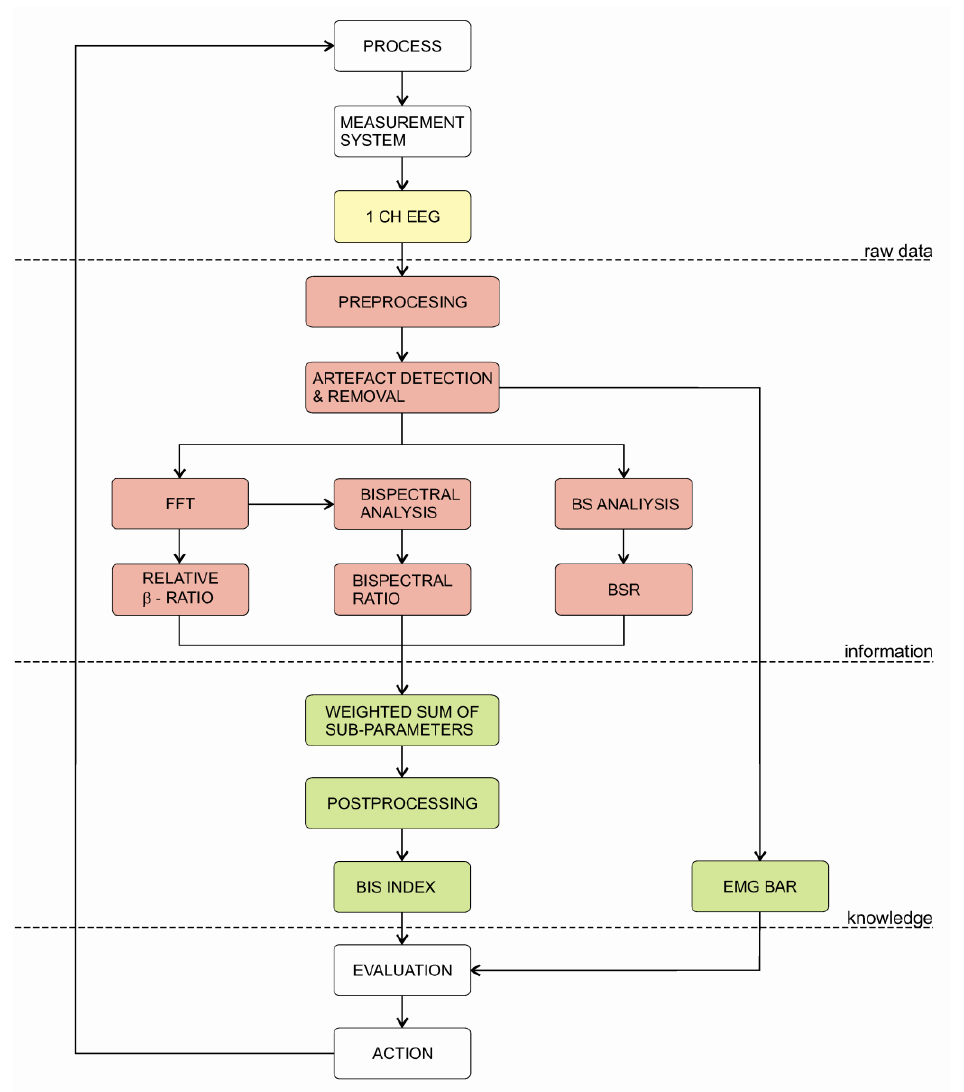
Figure 5. The block diagram of the BIS algorithm. Abbreviations: BSR (burst suppression ratio), electromyogram activity (EMG), FFT (fast Fourier